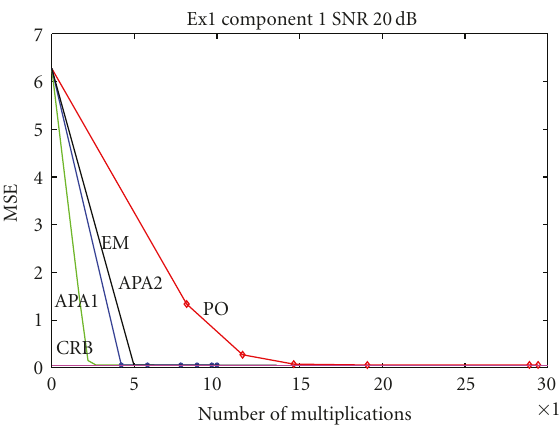
Figure 10: Experimental MSE versus computation cost for Ex1 at 20dB (component 1).